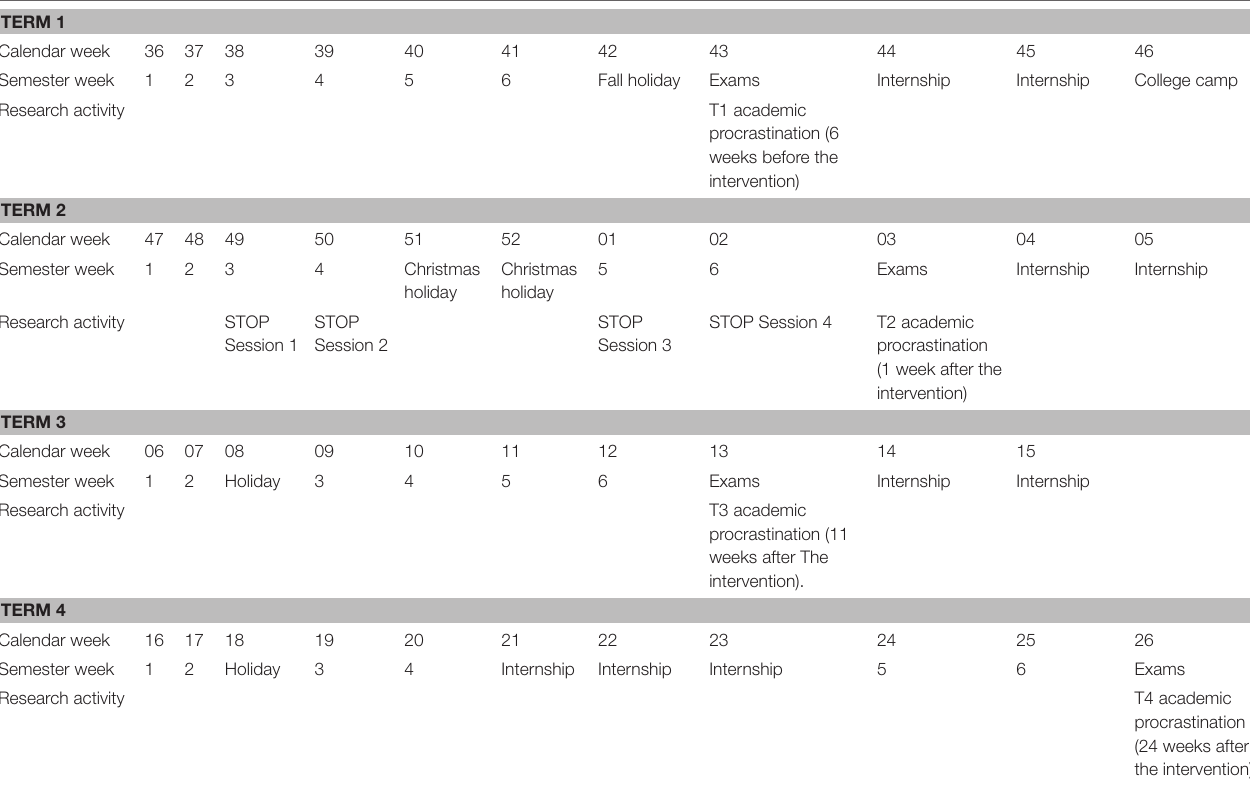
TABLE 1 | Overview of the academic year, measurement points, and intervention